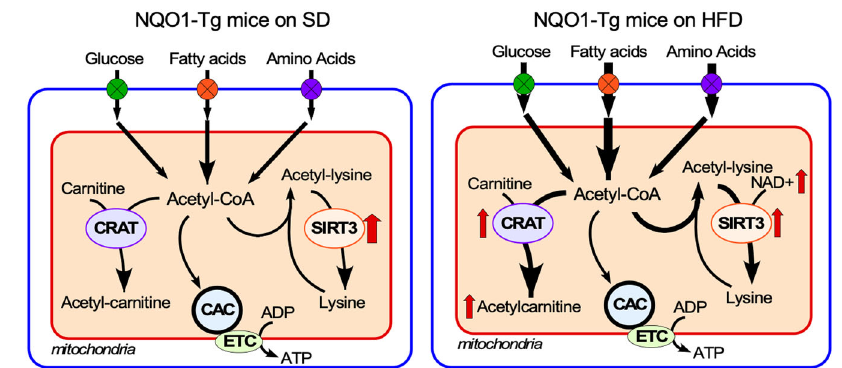
Fig. 7 Working model illustrating cooperative regulation of carnitine acetyltransferase (CRAT) activity coupled with SIRT3-mediated removal of the excess mitochondrial protein acetylation in the liver of NQO1-Tg mice-fed high-fat diet (HFD). NQO1 transgenesis increases the availability of NAD + , an essential cofactor for SIRT3 activity.